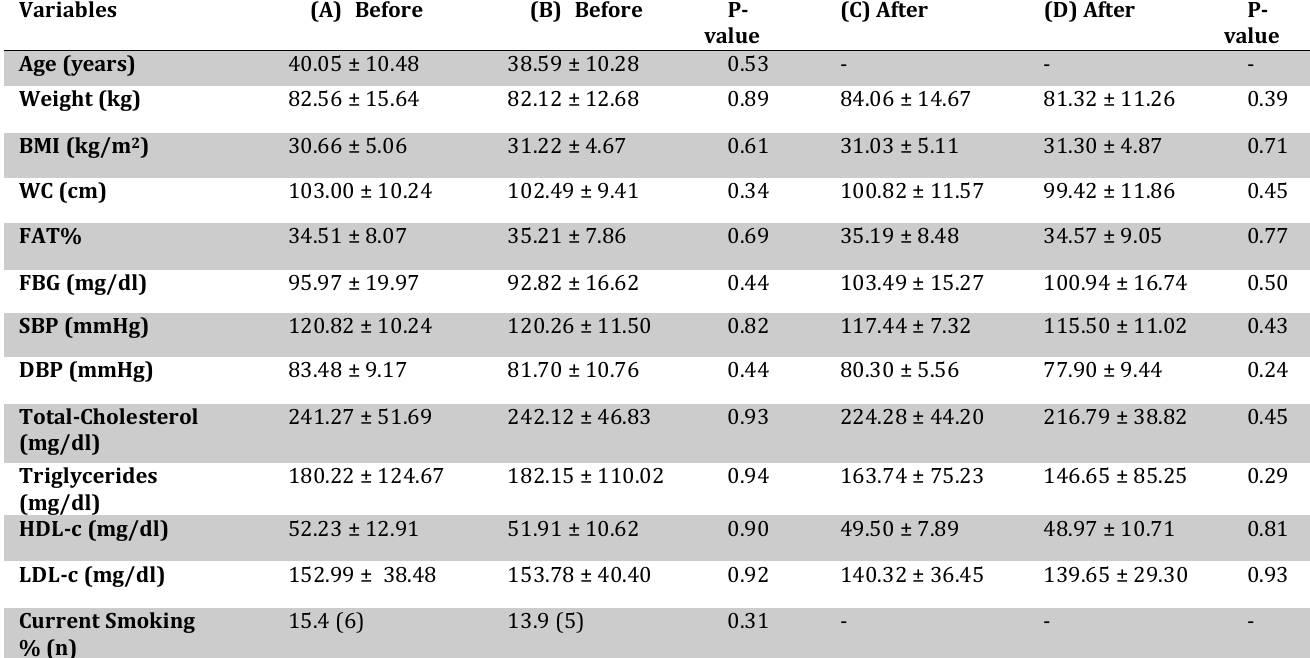
Table 1: Clinical and biochemical features in subjects before and after intervention Variables (A) Before (B) Before Age (years) Weight (kg)